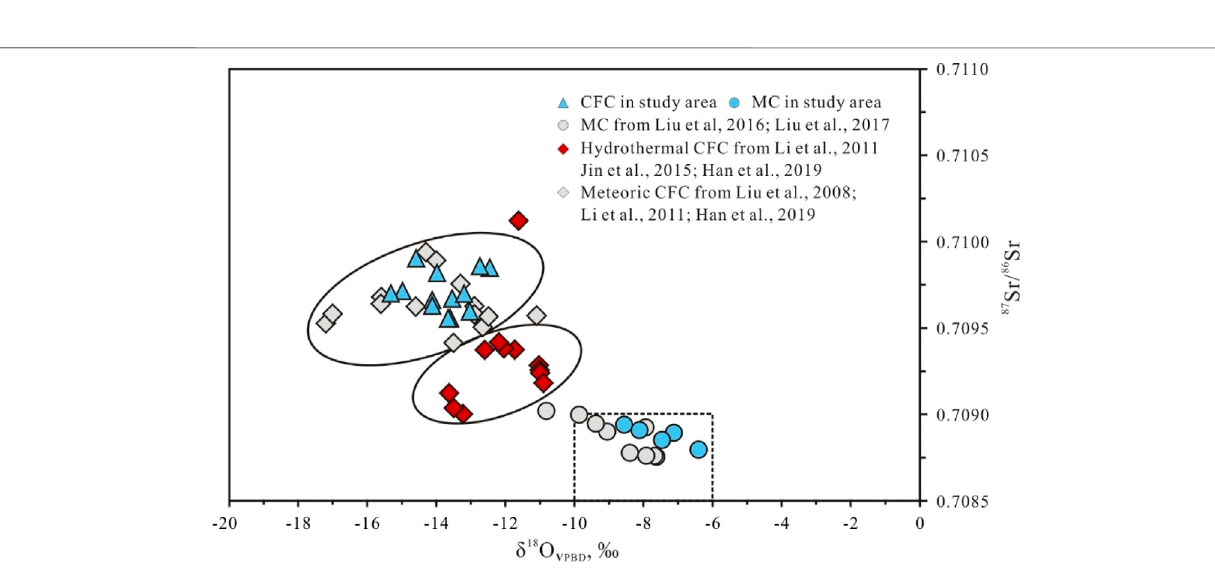
Frontiers in Earth Science |